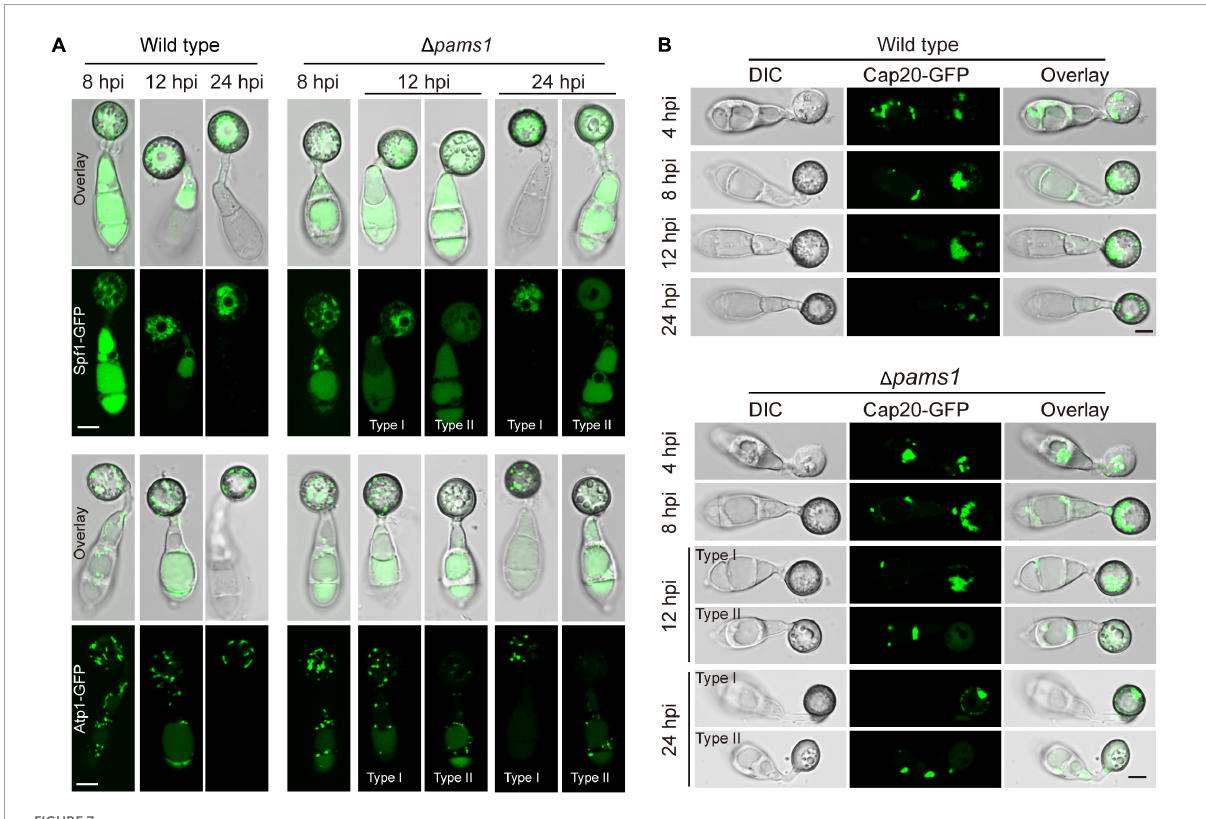
FIGURE7 Endoplasmic reticula, mitochondria, and lipid droplets in (cid:49) pams1 ’s appressoria. (A) Distribution of Spf1-GFP-marked endoplasmic reticula and Atp1-GFP-marked mitochondria in appressoria of the wild type and (cid:49) pams1 (types I and II abnormal appressoria) at 8, 12, and 24 hpi. (B) Distributions of lipid droplets in spores and appressoria at 4, 8, 12, and 24 hpi. Lipid droplets were marked by Cap20-GFP. Scale bar, 5 µ